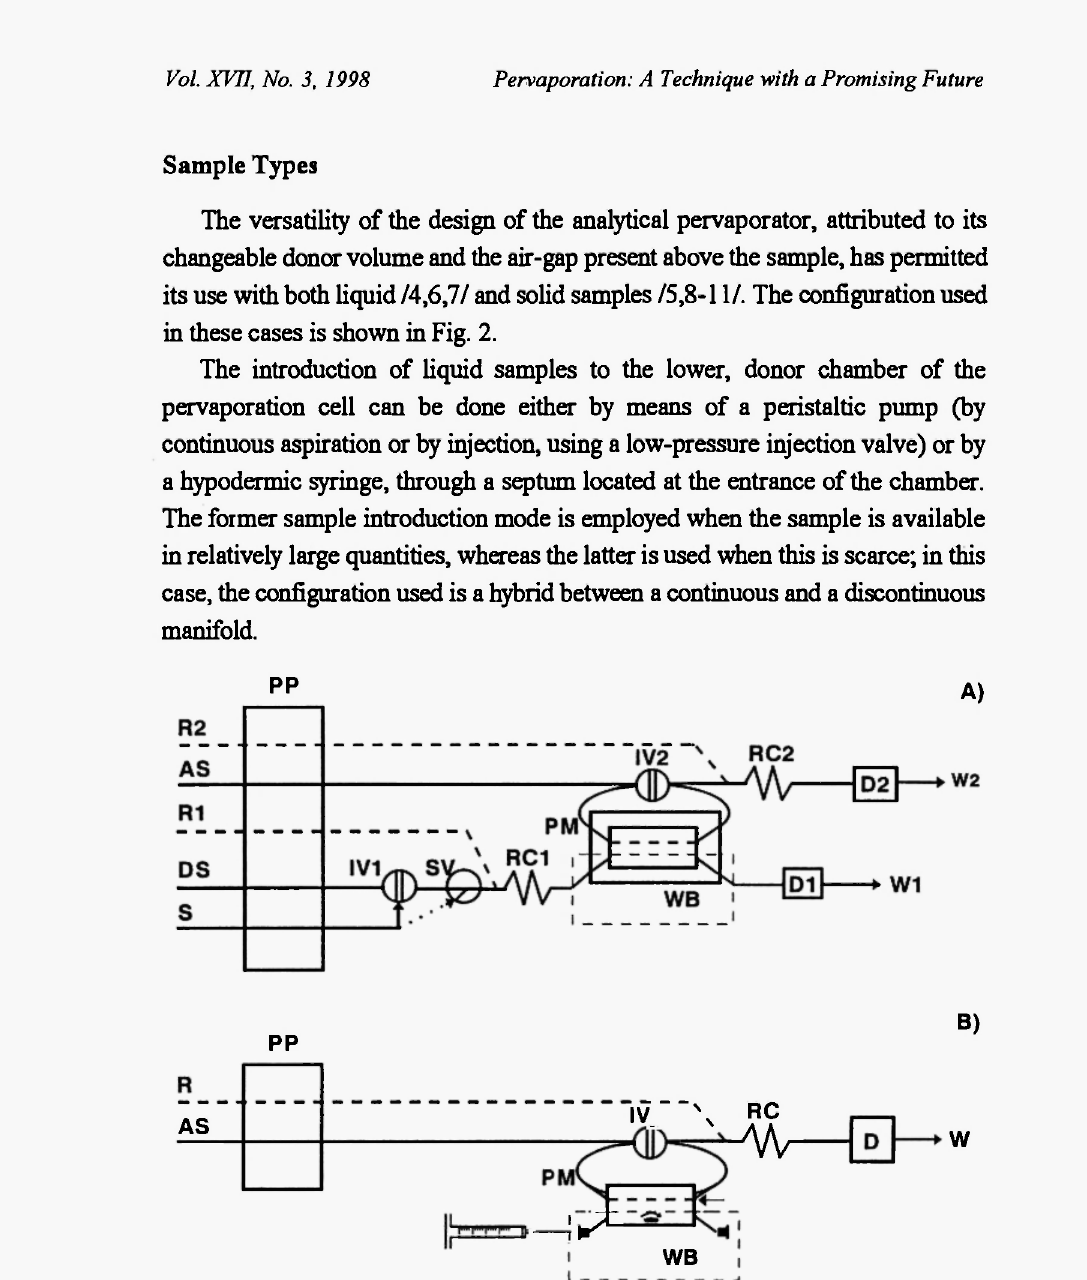
Fig. 2: Dynamic configuration-pervaporation assemblies A) for liquid samples and B) for solid samples. PP: peristaltic pump, IV: injection valve,